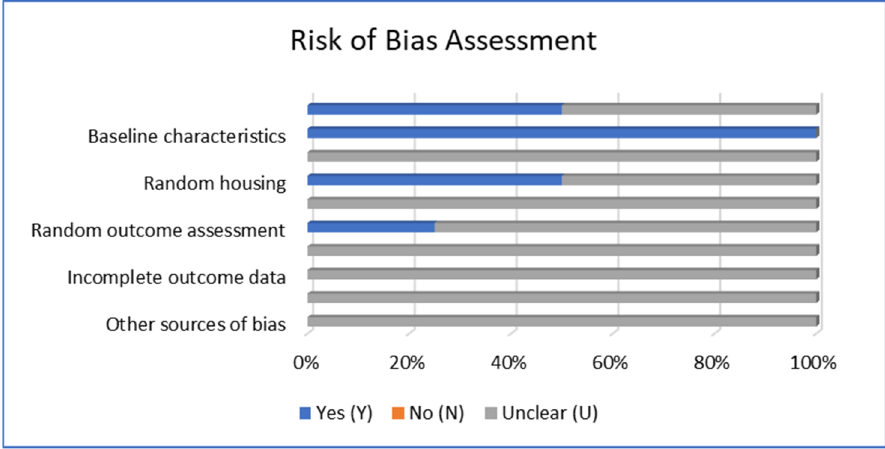
Figure 3. Risk of bias assessment using SYRCLE’s tool [27].